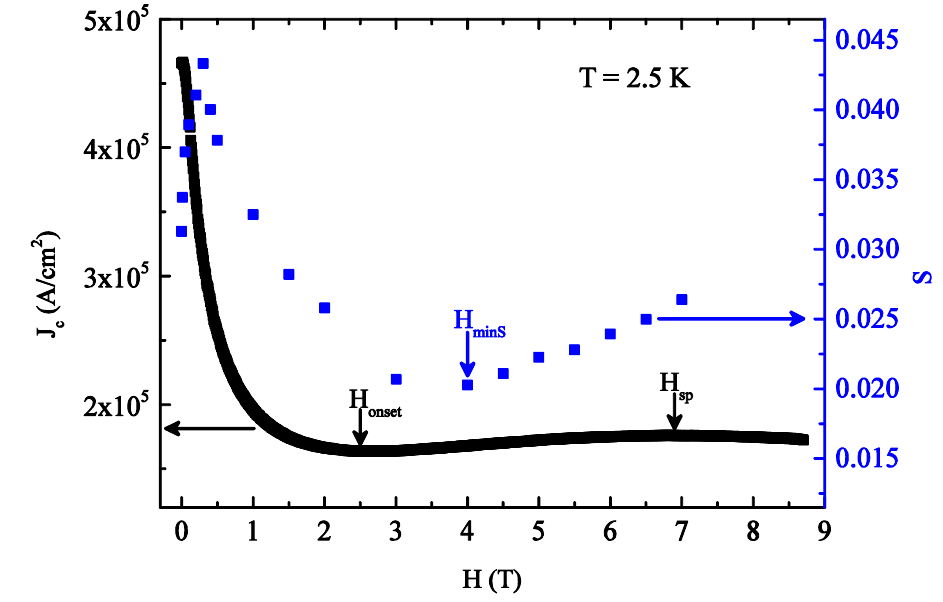
Figure 2. The field dependence of relaxation rate S (blue closed squares, right scale) shown together with the J c (H) curve (black closed squares, left scale) measured at the same temperature T = 2.5 K.